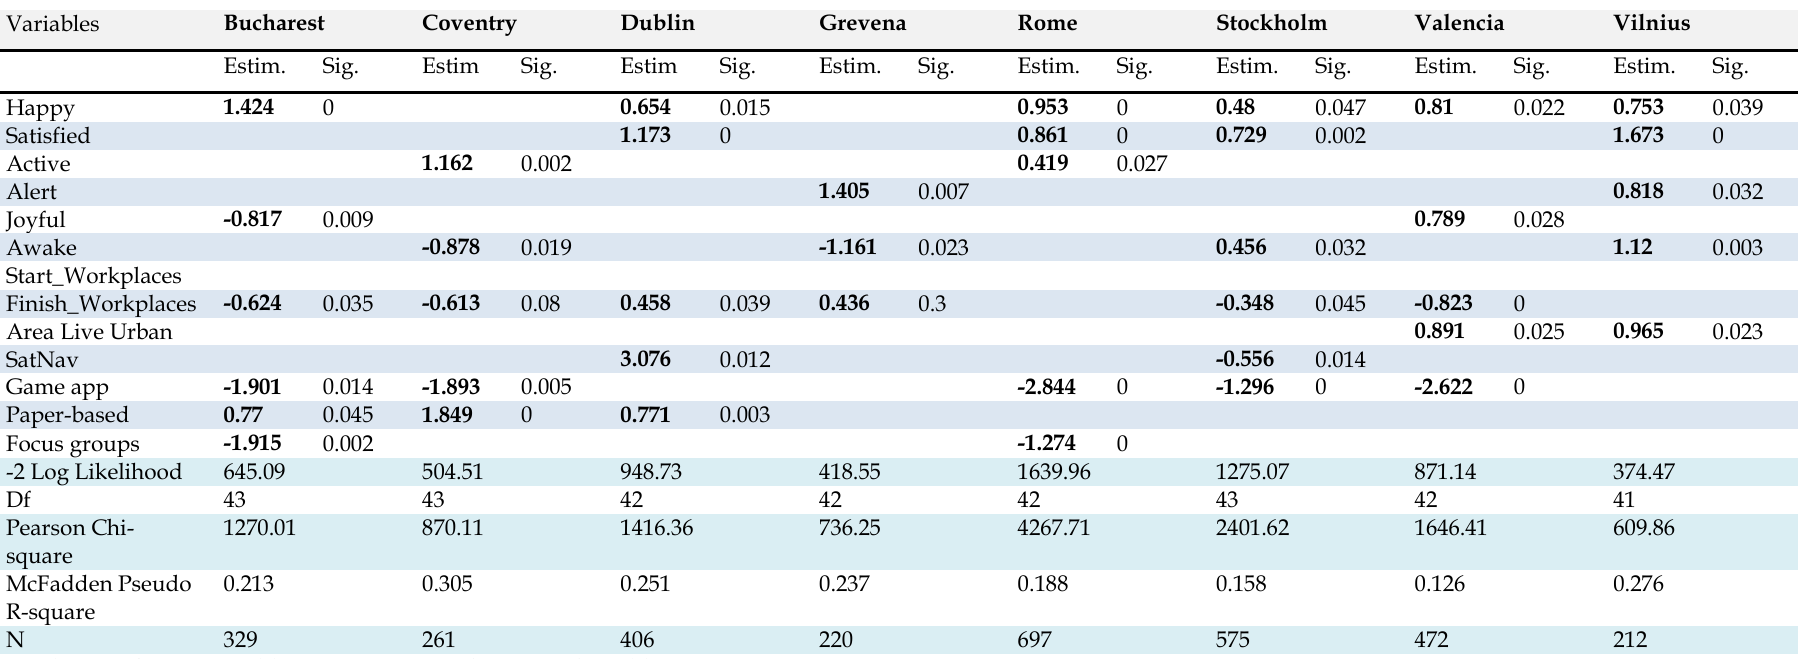
Table 6: Estimation results for M2 model